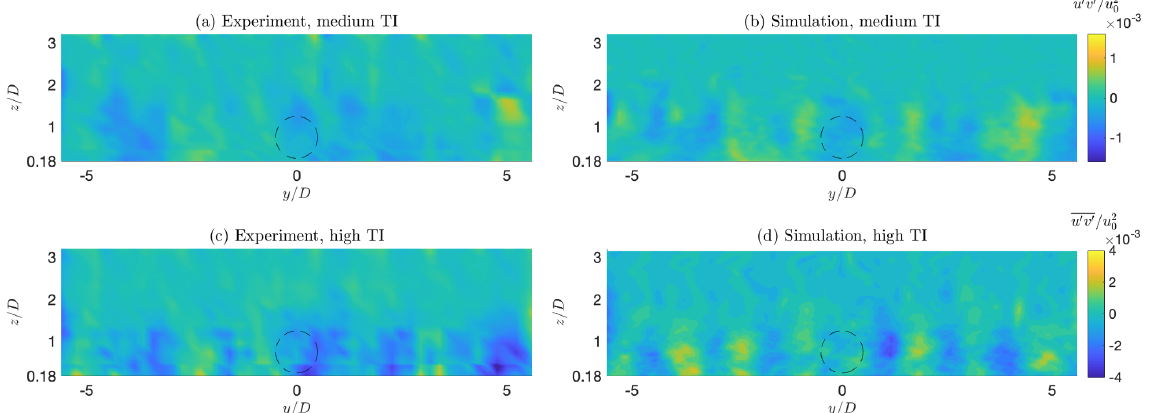
Figure 6. Shear stress distribution on a cross section of the test chamber 3.59 D in front of the rotor. (a, c) Experimental measurements; (b, d) numerical simulations; (a, b) medium-TI case; (c, d) high-TI case.